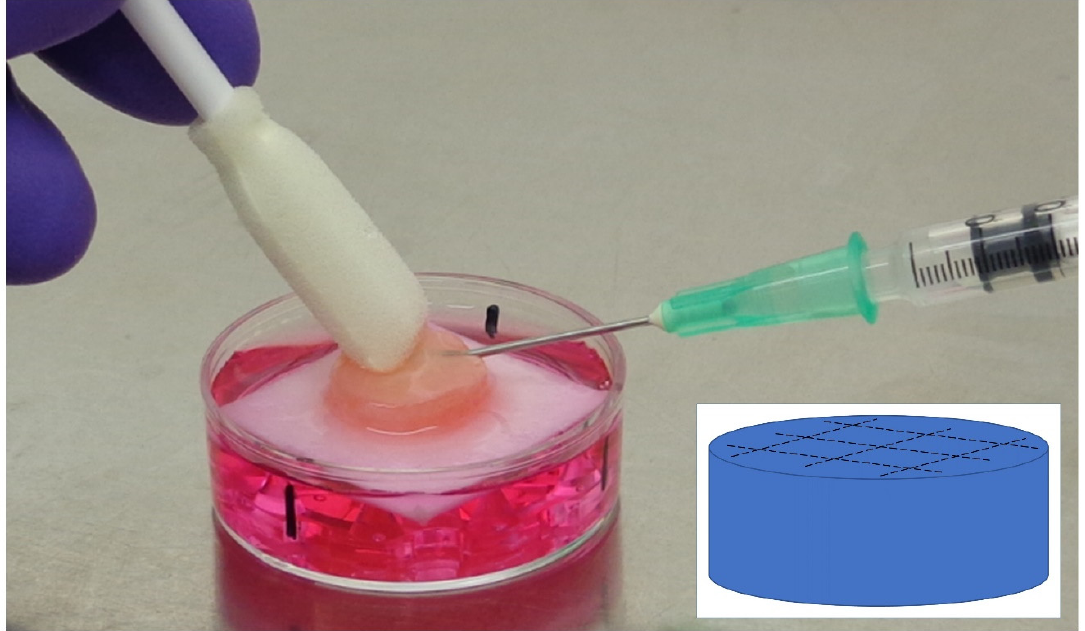
Figure 4. Injection of a dermal filler in the human Phenion ® Full-Thickness Skin Model. The inlay shows the used cross-hatching pattern.